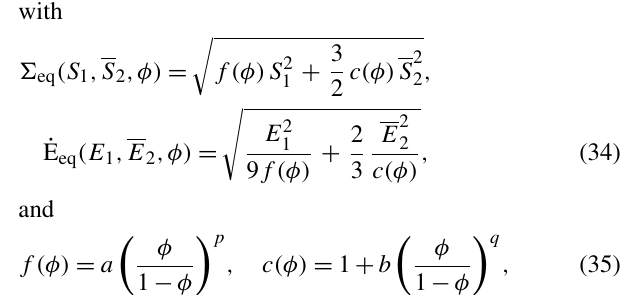
Figure 9. Oedometric compression test (a) and triaxial compression test (b)